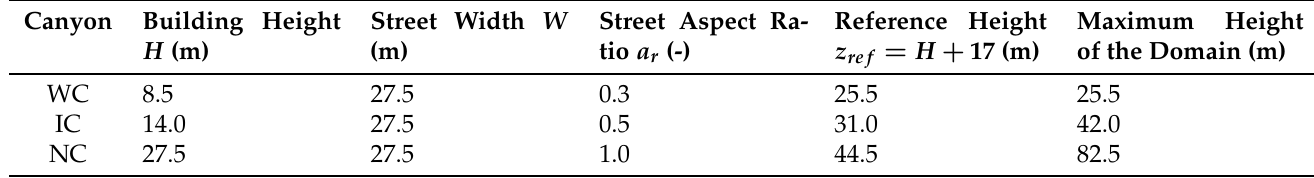
Table 1. Characteristics of the three canyons